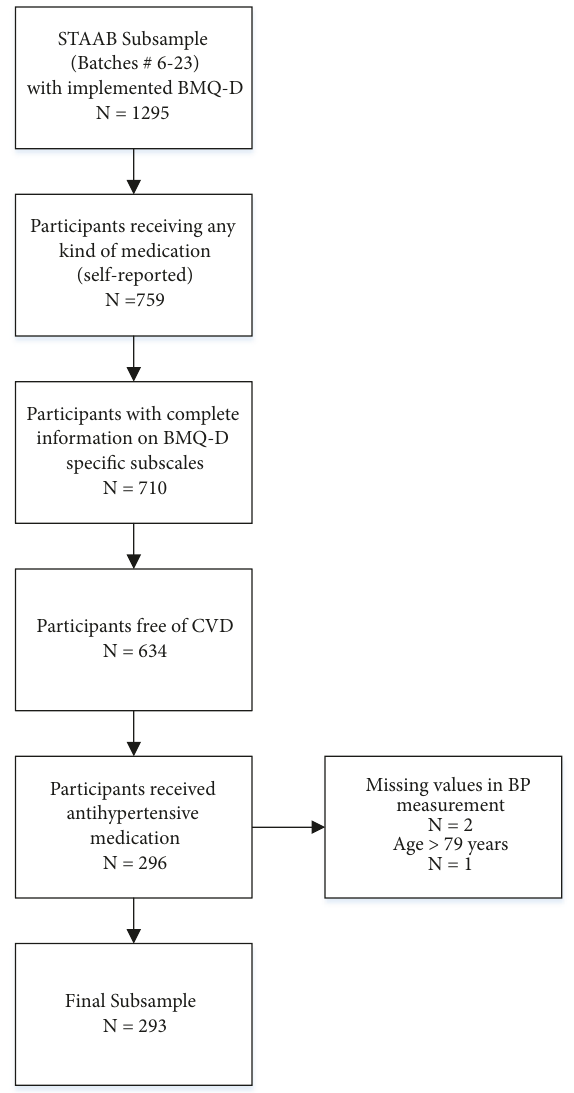
Figure 1: Sample Selection . BMQ-D, Beliefs about Medicines Ques- tionnaire (German version); CVD, cardiovascular disease; BP, blood